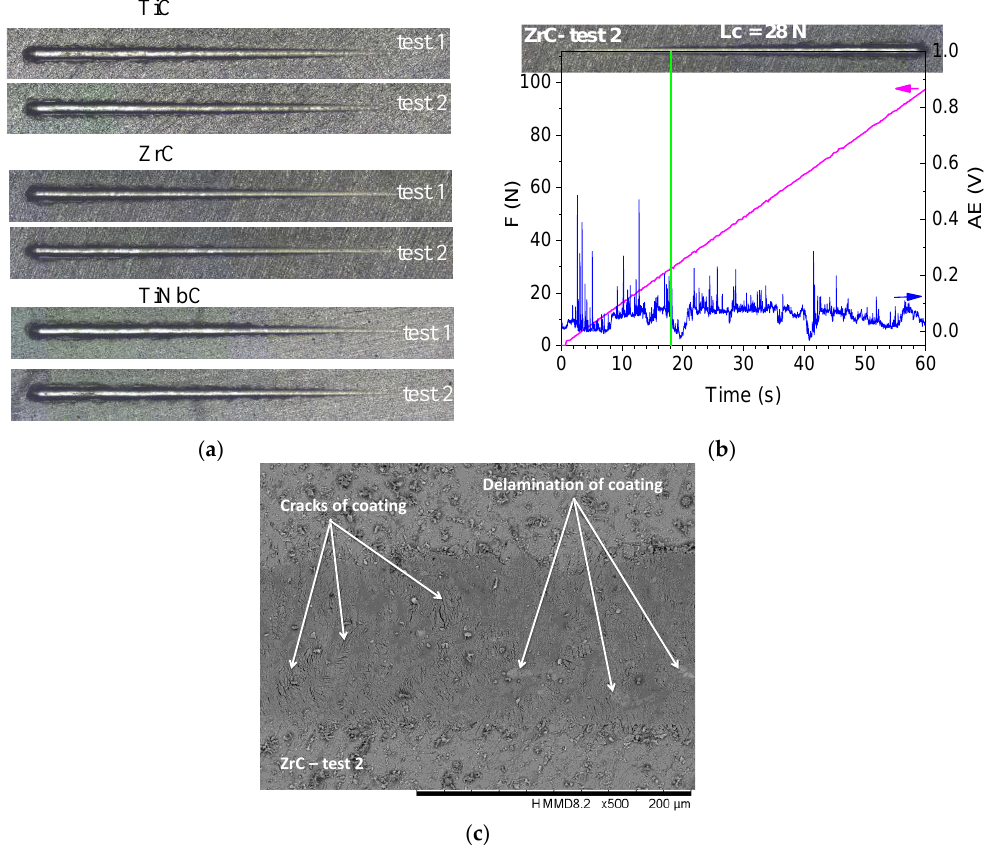
Figure 4. ( a ) Scratch tracks of the investigated samples determined using the following parameters: indenter—0.2 mm radius diamond tip, load—continuous increase from 0 to 100 N, scratching speed— 10 mm / min., scratching distance—10 mm [35]; ( b ) Time-compressed acoustic sensor signal envelopes of the whole scratch test of the ZrC coating (test 2); ( c ) detailed SEM image in the area of cracks/delamination of the ZrC coating.